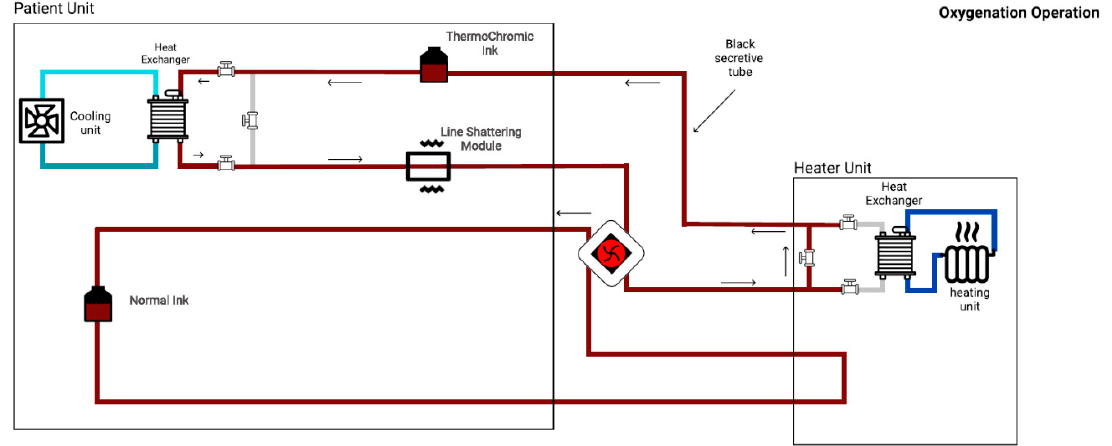
Figure 8. De-oxygenation process.